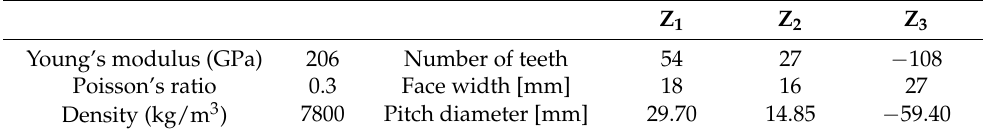
Figure 3. Geometrical model of the analyzed gearbox. Table 1. Material and geometrical properties of the gearbox. Table 1. Material and geometrical properties of the gearbox.